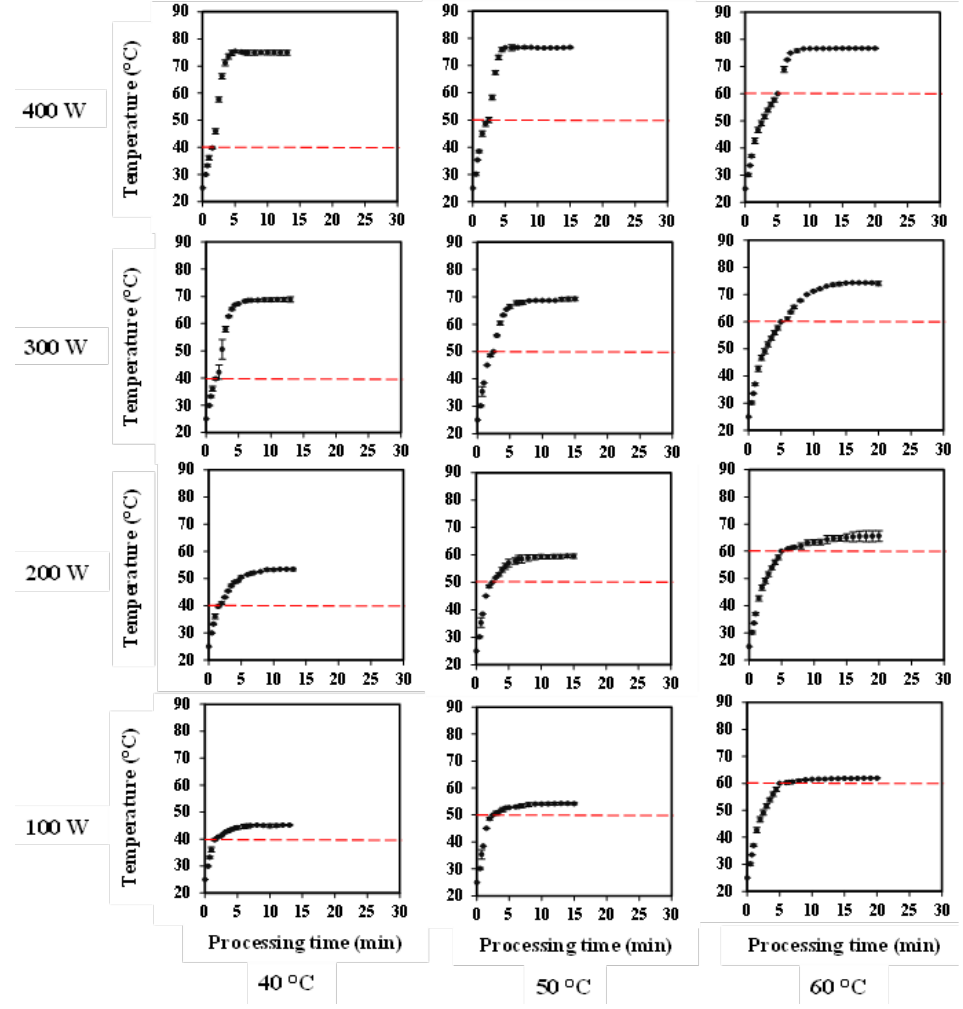
Figure 1. Thermal history of the processes of extraction by thermosonication.